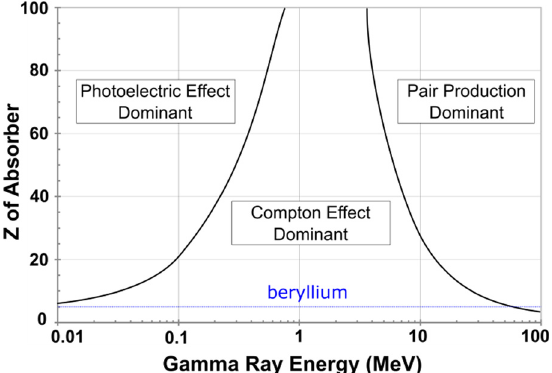
Fig. 8. Dominant gamma interactions depending on the incident gamma energy and the proton number of the target.